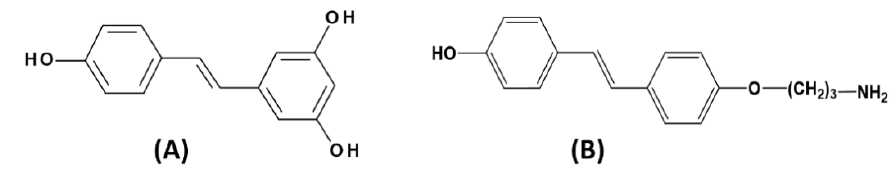
Figure 1. Chemical structure of ( A ) the natural trans-resveratrol molecule (RSV) and ( B ) the trans-resveratrol derivative molecule: 4’-hydroxy-4-(3-aminopropoxy) trans-stilbene (HAPtS).